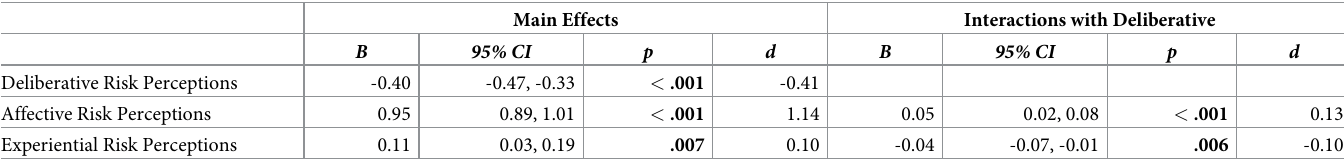
Table 3. Main effects and interactions among three risk perceptions in predicting protection motivation ( n =